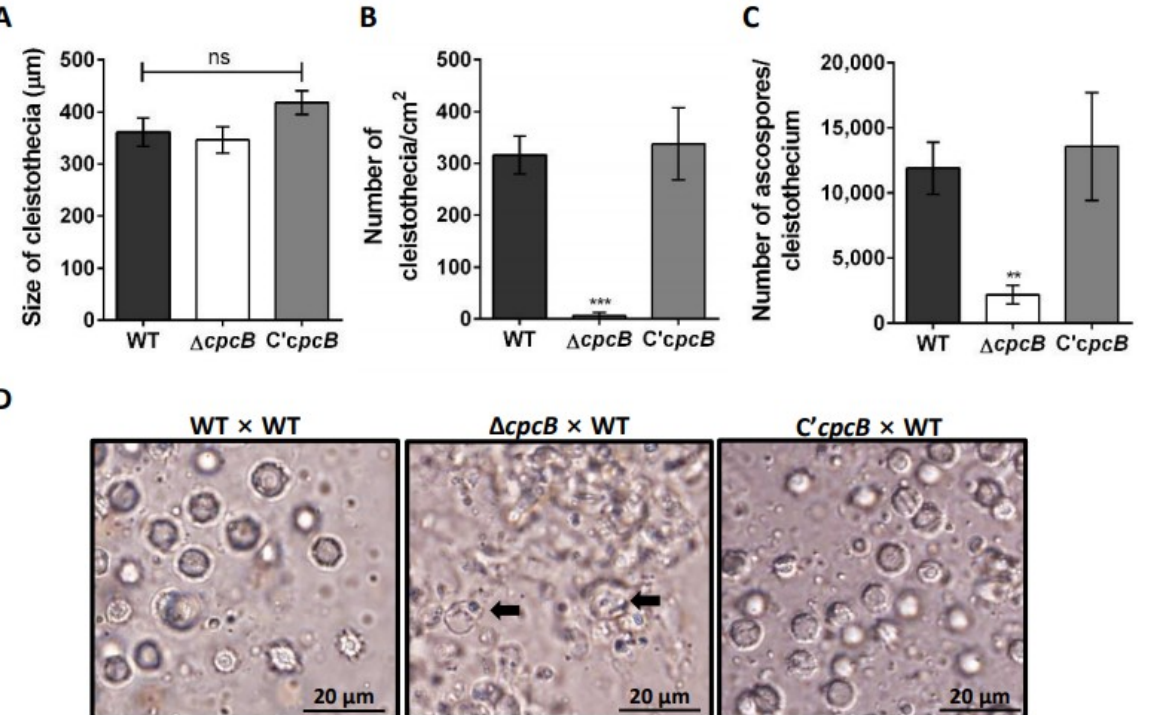
Figure 2. Effects of Af CpcB on sexual development. WT × WT pair (AFB62 and AFIR928 strains), Δ cpcB × WT pair ( Δ AfcpcB and AFIR928 strains) and C’ AfcpcB × WT pair ( C’ AfcpcB and AFIR928 strains) were used for sexual development induction by the vegetative mass mating method. ( A ) Size of cleistothecia. Diameter of randomly selected cleistothecia was measured using ImageJ soft- ware ( n = 8). “ns” indicates not significantly different. ( B ) Quantification of the number of cleisto- thecia ( n = 4). Statistical analysis was performed using Student’s t -test. *** p < 0.001. ( C ) Number of ascospores in a cleistothecium. Each cleistothecium was ruptured using 0.05% tween80 and counted using a hemocytometer ( n = 8). Statistical analysis was performed using Student’s t -test. ** p < 0.01. ( D ) Differential interference contrast microscopic images of ruptured cleistothecia of 14-day-old cul- tures. Black arrow indicates irregular-shaped ascogenous cells.